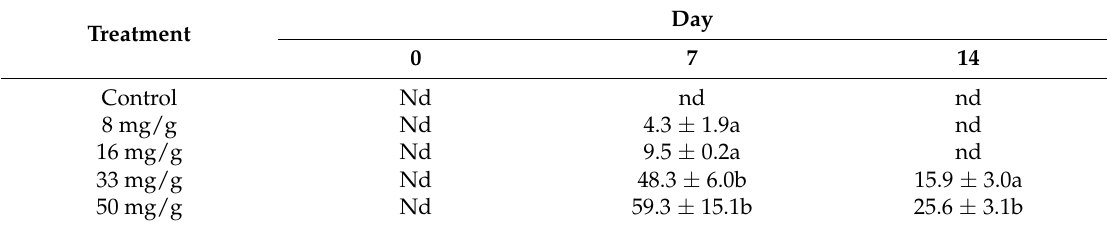
Table 1. AITC adsorbed (mg/kg) by the pita bread, treated with different concentration of oriental mustard flour sauce contained in a bioactive sachet and introduced inside the bread